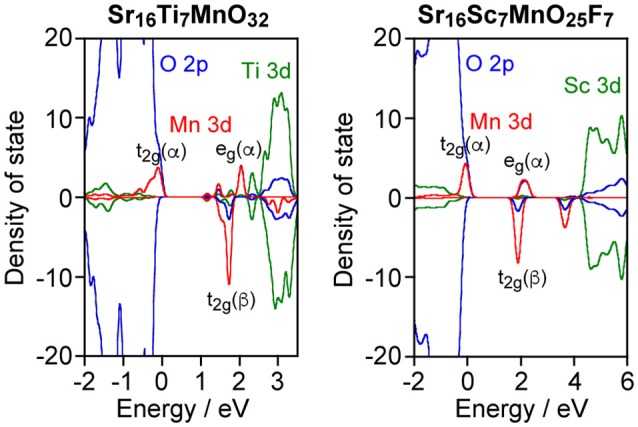
PDOS of Sr16Ti7MnO32 and Sr16Sc7MnO25F7.